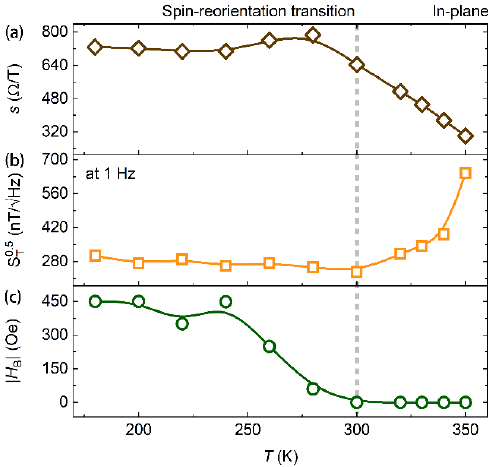
Figure 4. ( a ) Sensitivity s , ( b ) magnetic field detectability 𝑆 T0.5 at 1 Hz, and ( c ) the bias field 𝐻 B at which the best field detectability is achieved, as a function of temperature 𝑇 . The vertical gray dotted line represents the temperature (300 K) where the anomalous Hall sensor attains the best performance.